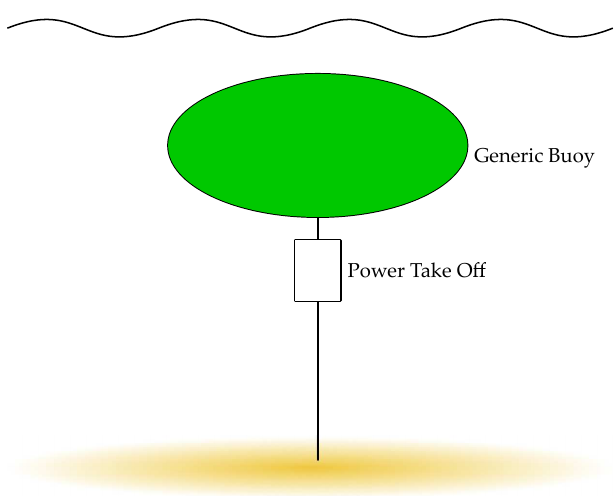
Fig. 1. A single tether submerged generic PA